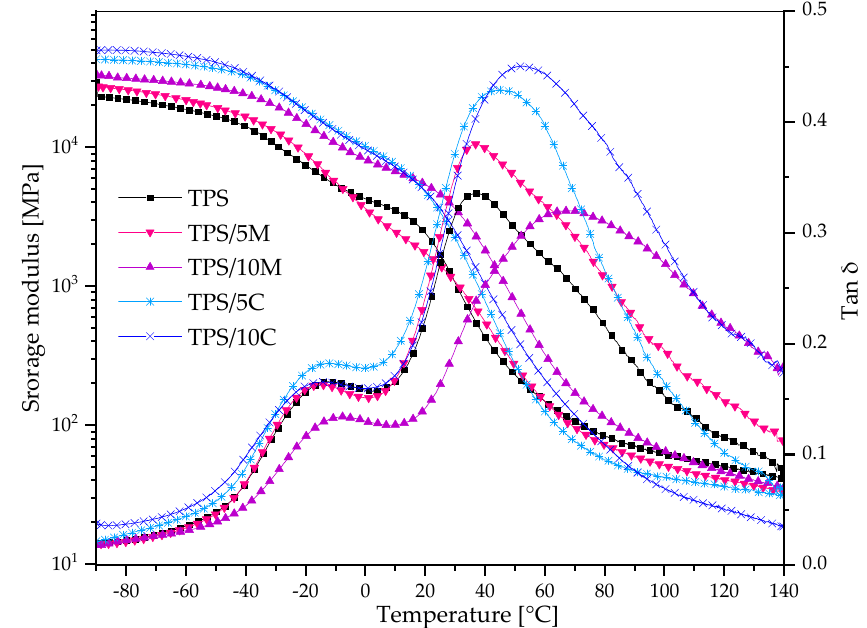
Figure 1. Storage modulus and Tan δ curves of TPS films.